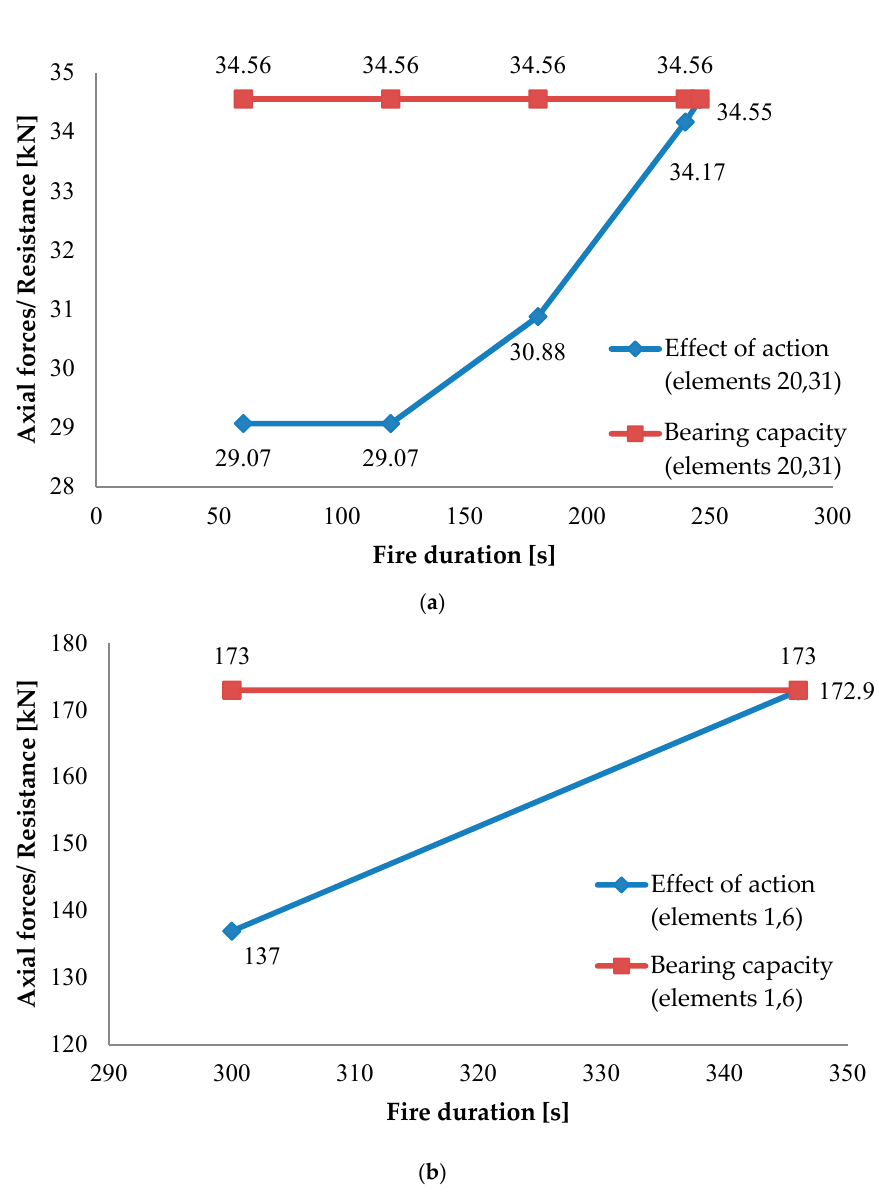
Figure 7. The change of axial forces and resistance with fire duration (truss “B”): ( a ) elements 20, 31 and ( b ) elements 1, 6.